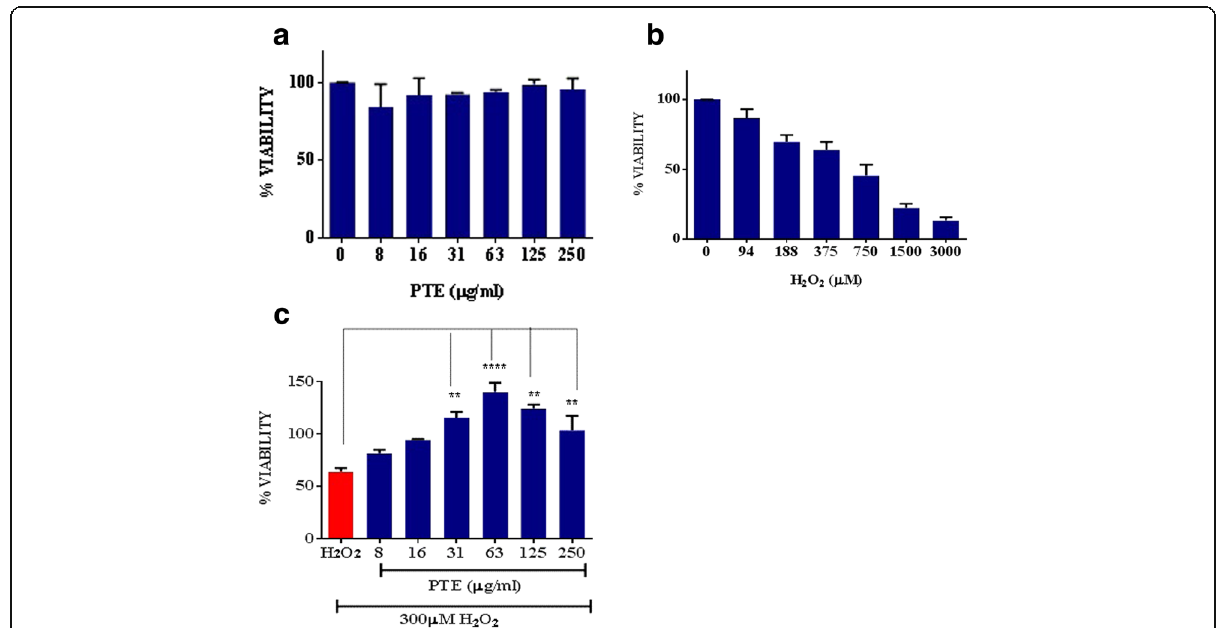
Fig. 3 a Effect of PTE on dIMR32 cells viability after exposure for 24 h. No statistical difference were observed between doses. b Effect of H 2 O 2 on dIMR32 cells viability after exposure for 24 h. There is a dose-dependent reduction in viability of dIMR32 cells. c Neuroprotective effect of PTE pre- treatment (24 h) against H 2 O 2 induced cytotoxicity in dIMR32 cells. The data are expressed as mean ± SEM, n = 3. Statistical significance was ana- lyzed with one-way analysis of variance followed by Dunnett ’ s multiple comparison post-hoc test. Differences with p value less than 0.0001 and p